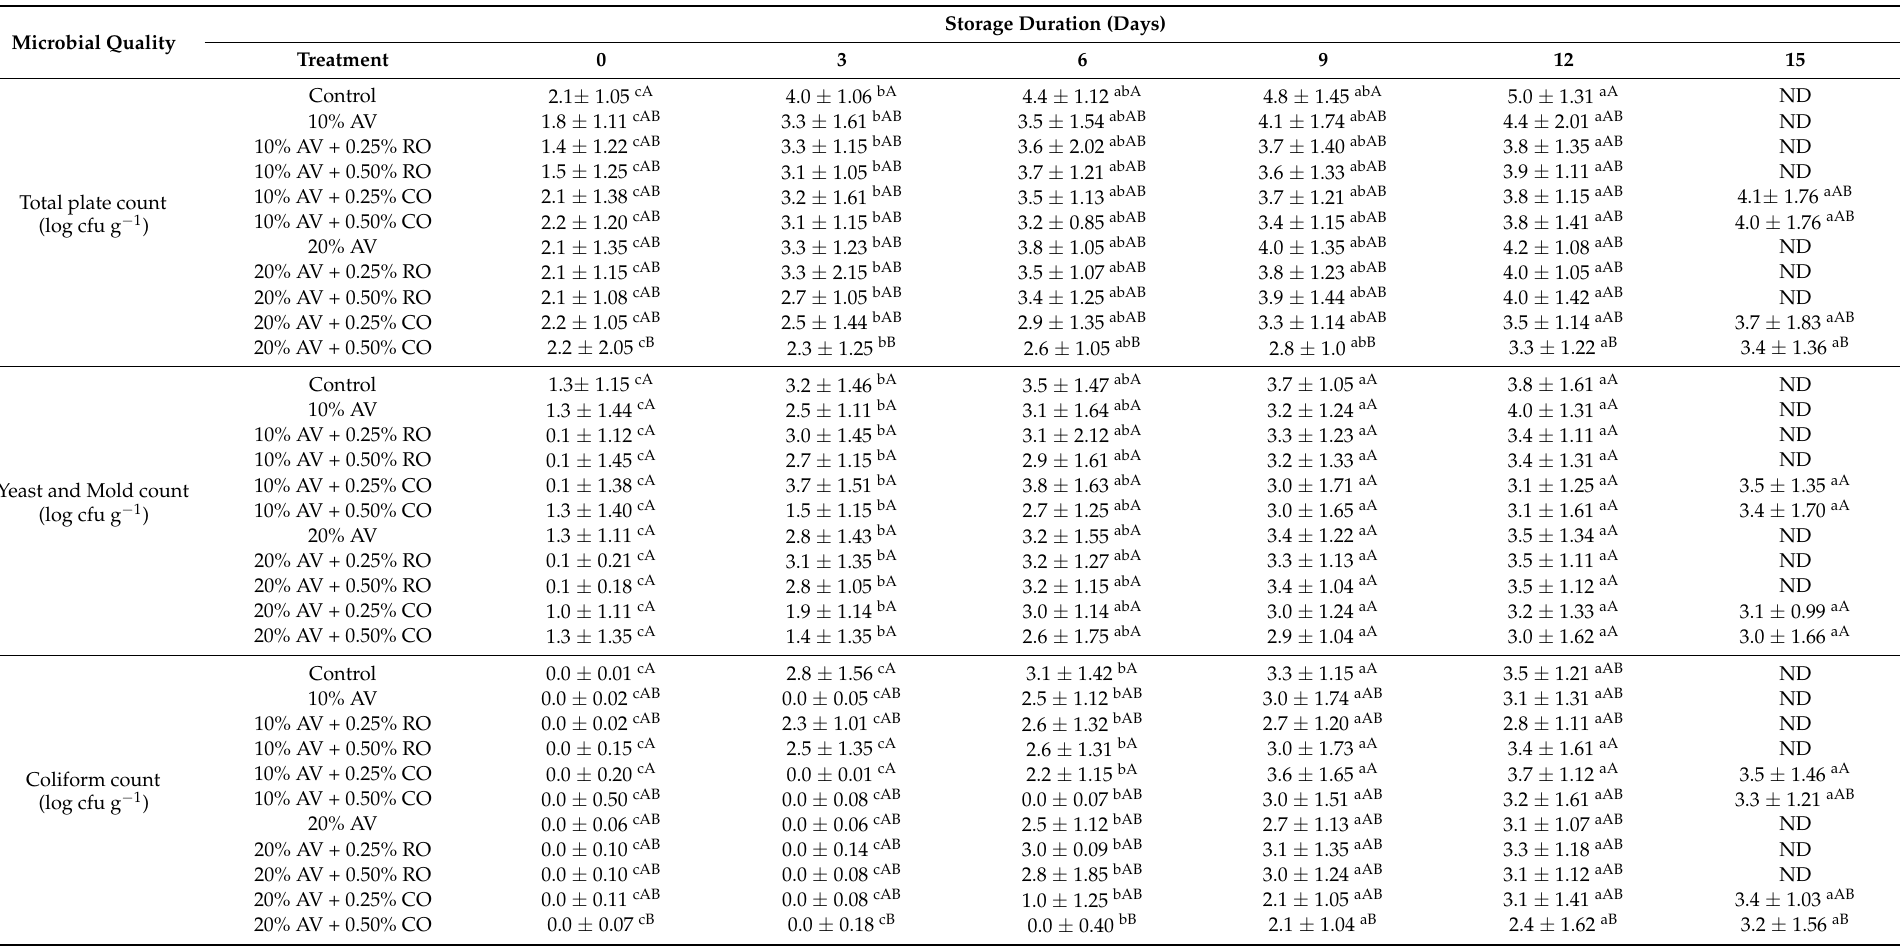
Table 2. Effects of Aloe vera (AV) gel coating that was enriched with rosehip oil (RO) (0.25% or 0.50%) and cinnamon oil (CO) (0.25% or 0.50%) on the yeast and mold counts (log CFU g − 1 ) and total plate count (log CFU g − 1 ) of ‘Bhagwa’ pomegranate arils during storage at 5 ± 1 ◦ C (95 ± 2% RH) for 15